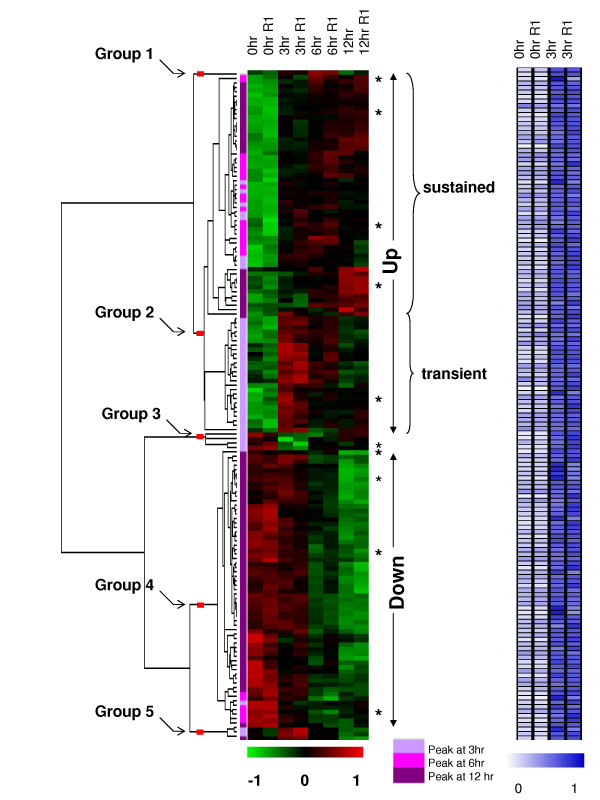
Hierarchical cluster analysis of gene expression estimates from the expresssion microarrays and the heat map of binding ratios of the ChIP-chip experiments of the 150 TGF-β/SMAD target genes in IOSE cells. Genes that showed both altered expression at 3, 6, or 12 hrs relative to 0 hr (low-green and high-red) and altered binding at 3 hrs compared to 0 hr (low-white and high-blue) after TGF-β signaling stimulation were shown. The expression data were median-centered and normalized to have a unit sum of squares for each gene before transforming to the color scale. Genes that were confirmed by ChIP-PCR and RT-PCR are indicated by asterisks. Results from the ANOVA analysis indicating the peak time point relative to 0 hr is indicated by a color bar. The experiments labeled R1 were biological replicates in the expression microarrays and were technical replicates in the ChIP-chip experiments. In the Chip-chip experiments, normalized binding ratios to have a unit sum of squares for each gene were used for the heatmap.